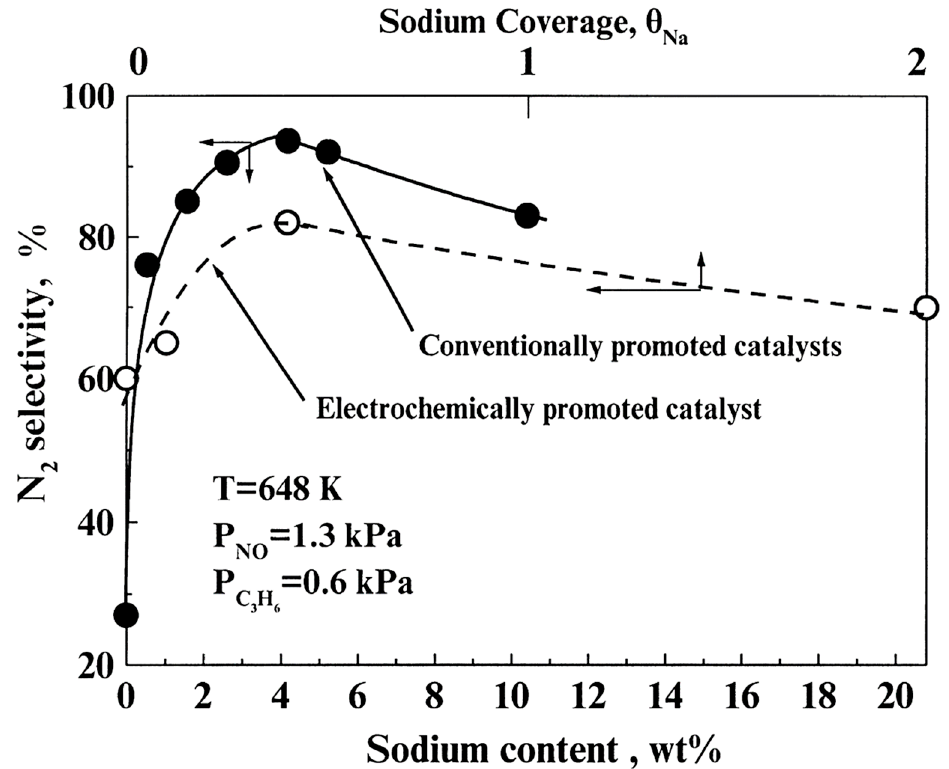
Figure 4. Comparison of electrochemically promoted (EPOC) and conventionally promoted (CCP) Pt with respect to N 2 -selectivity under the NO + C 3 H 6 reaction at T = 375 °C and [NO] = 1.3%, [C 3 H 6 ] = 0.6% feed. Similar well-correlated dependences of the variation of N 2 -selectivity on promotion (EPOC and CCP) applied. EPOC was performed in a Pt/(Na) β ’’ Α l 2 O 3